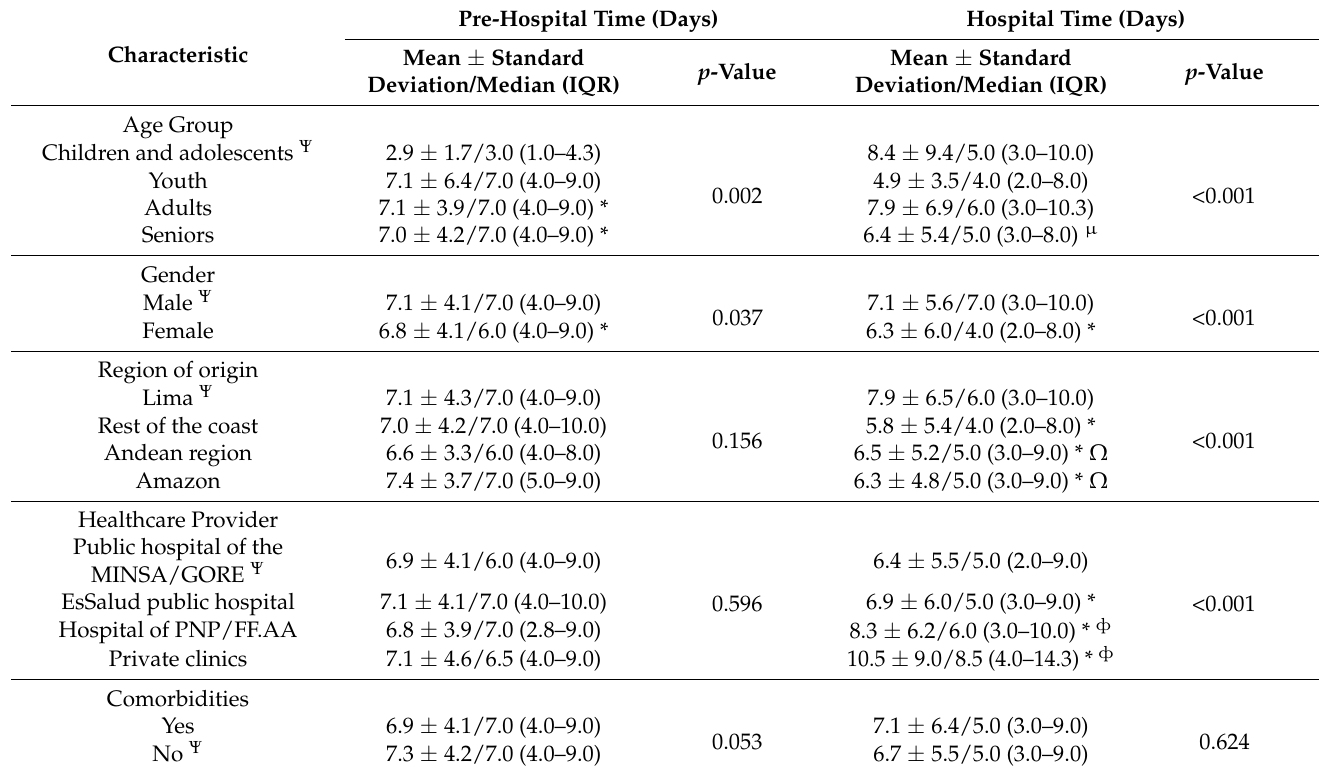
Table 4. Comparison of means and medians of pre-hospital and hospital time (days) with epidemio- logical characteristics of deaths from COVID-19 in